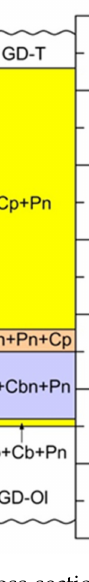
Figure 2. Cross-section of the Southern-2 ore body along the EM-7 borehole. Abbreviations: Cbn —cubanite; Cp—chalcopyrite; Pn—pentlandite; Po—pyrrhotite; GD-OL—olivine gabbro-dolerite; GD-T—taxitic